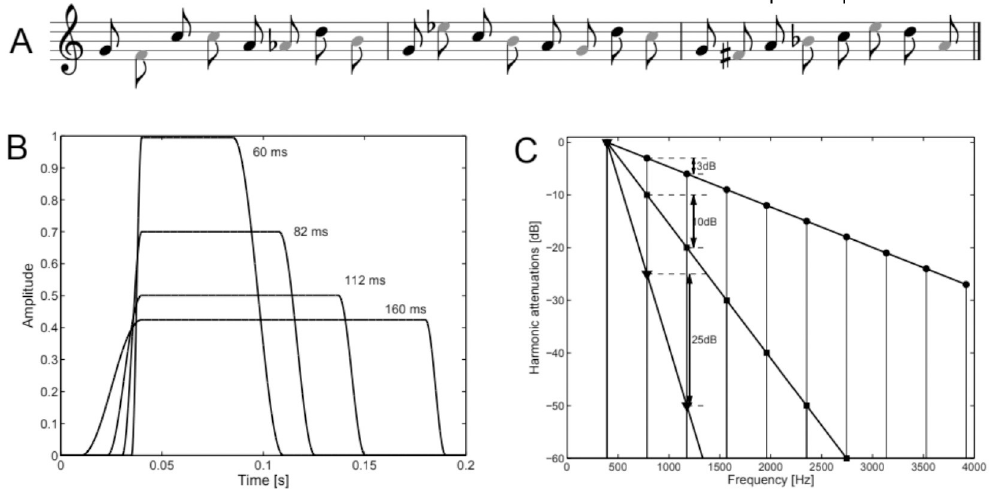
Fig 1. Illustration of stimuli and feature manipulations. (A) Sample stimuli, where black note heads depict the target pattern while grey note heads depict the distractor sequence. An example of a deviant target is given in the third measure, where the two notes marked by the bracket were reversed in order. (B) Temporal envelopes varying in impulsiveness from 60 ms FDHM (full duration at half-maximum) to 160 ms FDHM (the target notes). Only 4 of the 20 possible temporal envelopes are shown here. (C) Spectral envelopes varying from 3 dB of attenuation per harmonic (the target notes—circles) to 25 dB of attenuation per harmonic (triangles). Only 3 out of the 20 possible spectral envelopes are shown here. Fig adapted from Marozeau et al. (2013), with